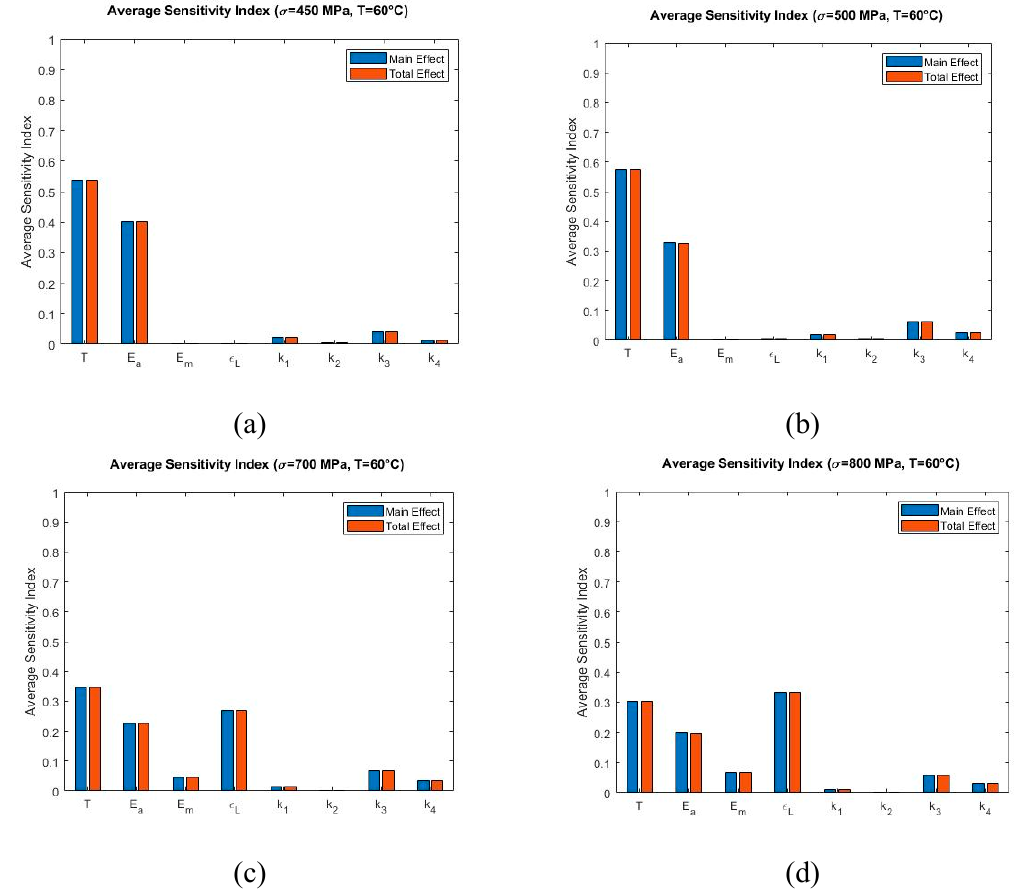
Figure 11. Sobol average sensitivity indices at simulated temperatures and maximum loading stress: ( a ) T = 60 ◦ C, σ max = 450 MPa ( b ) T = 60 ◦ C, σ max = 500 MPa ( c ) T = 60 ◦ C, σ max = 700 MPa ( d ) T = 60 ◦ C, σ max = 800